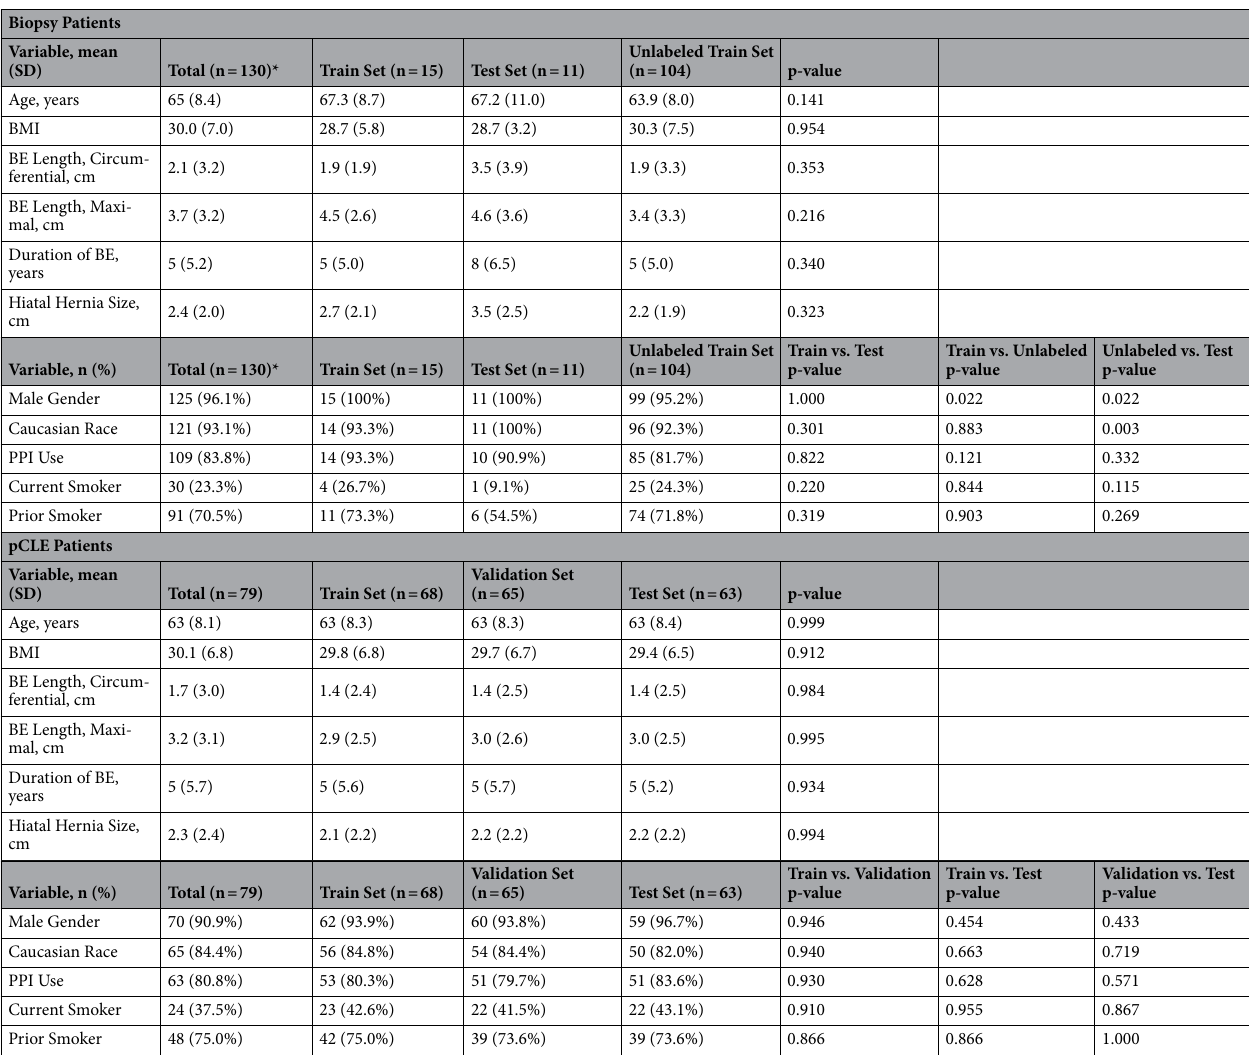
Table 1. Basic patient characteristics. * Labeled train and test sets comprise a relatively small number of labeled patient data compared to the total (25 of 130 patients). The remaining data (n = 104) were used in the unlabeled training set for the patch-level semi-supervised learning model. Basic patient characteristics, subdivided by pCLE versus biopsy and by training versus validation versus test set for the models. Note that a given individual patients’ biopsy or pCLE data may have been placed into multiple datasets, but the specific sequences and biopsies in each dataset were unique and without